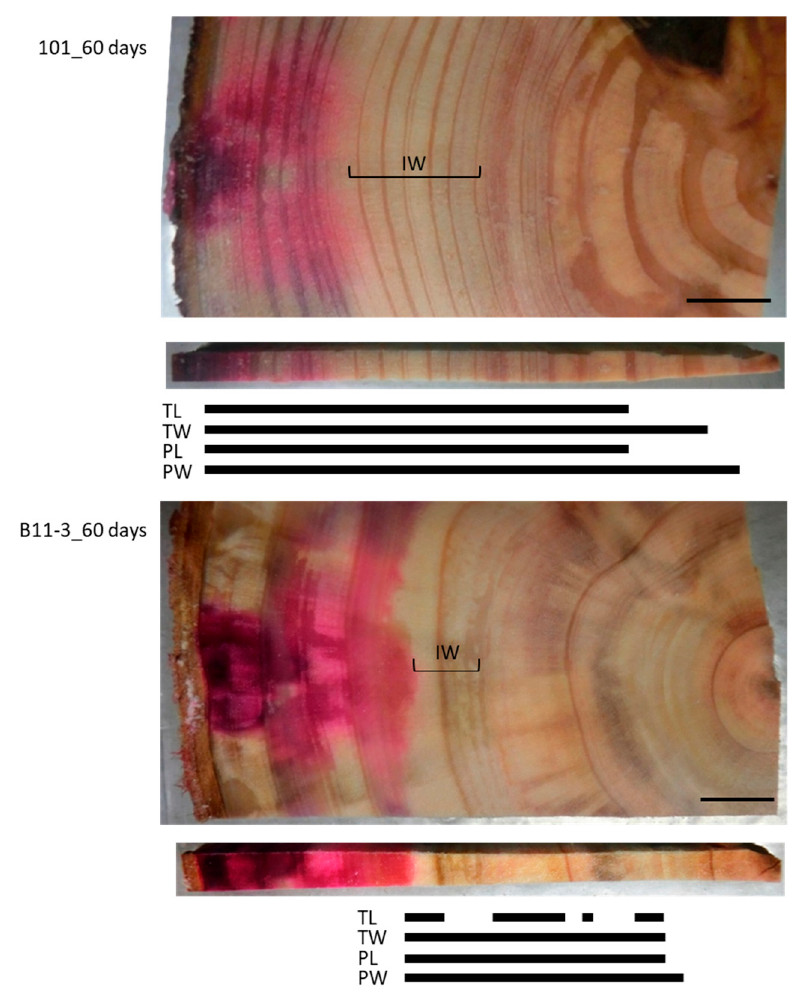
Figure 4. Schematic representation of radially distributed cesium (Cs) in the xylem of normal Japanese cedar ( Cryptomeria japonica ) trees after 60 days of injection, as observed using cryo-scanning electron microscopy / energy-dispersive X-ray spectroscopy (cryo-SEM / EDX). IW, intermediate wood area; other abbreviations are the same as described in Figure 2.